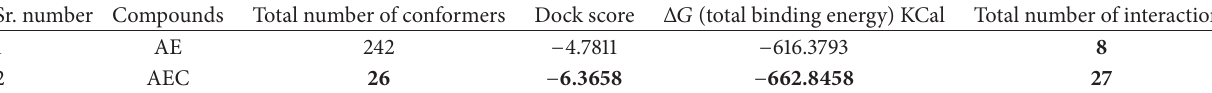
Table 1: The docking score and binding free energy of aloe emodin and its derivative.